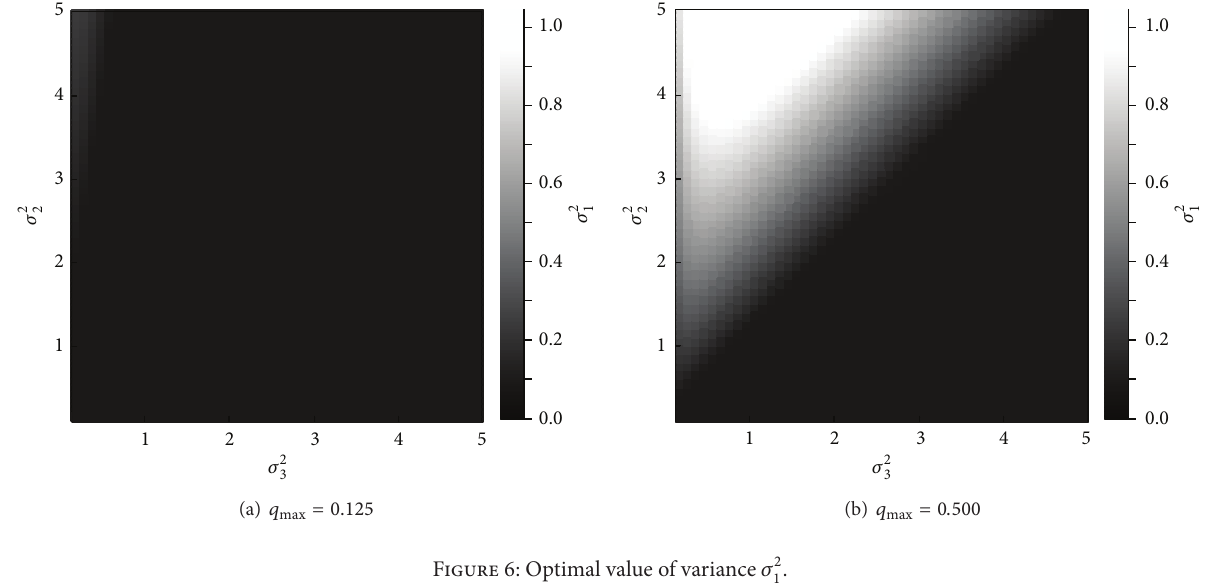
Figure 6: Optimal value of variance 𝜎 2 1 .